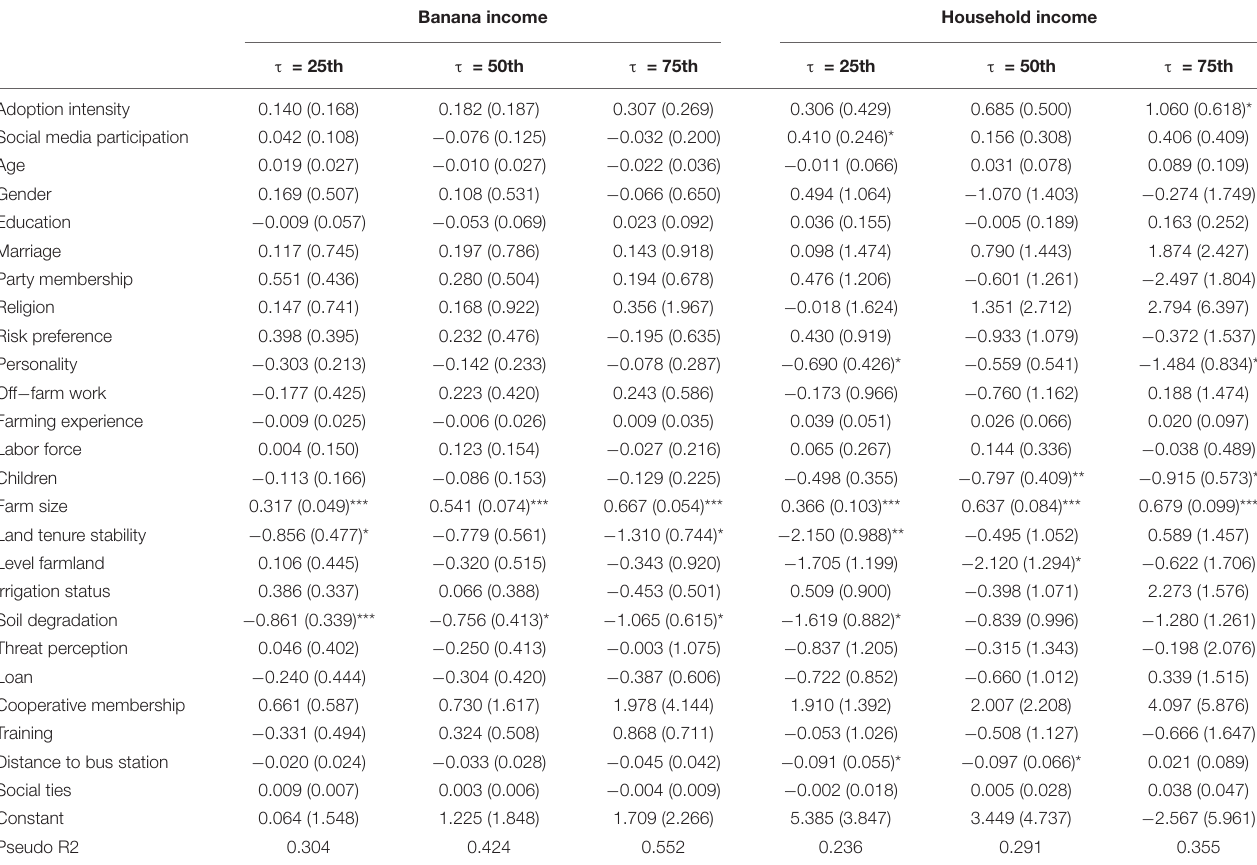
TABLE 8 | Impact of social media participation and LAPs on farmers’ incomes.